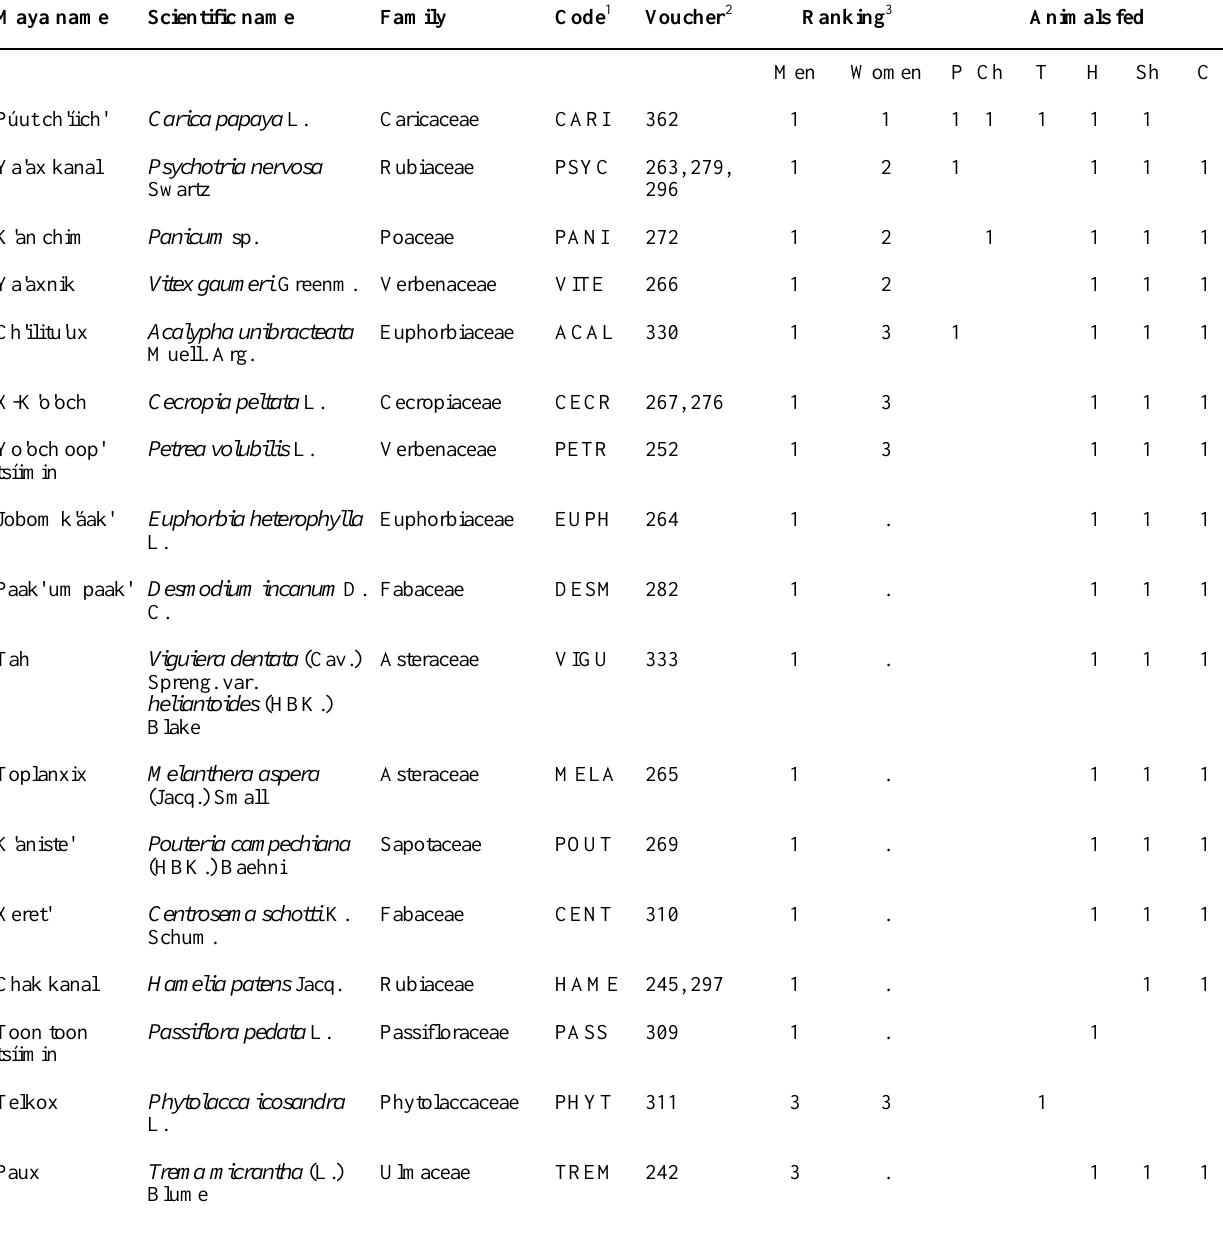
Table 1. Forage species included in this study, with their uses and importance ranking according to focus groups with men and women. Animals are P = pigs, Ch = chickens, T = turkeys, H = horses, Sh = sheep, C =